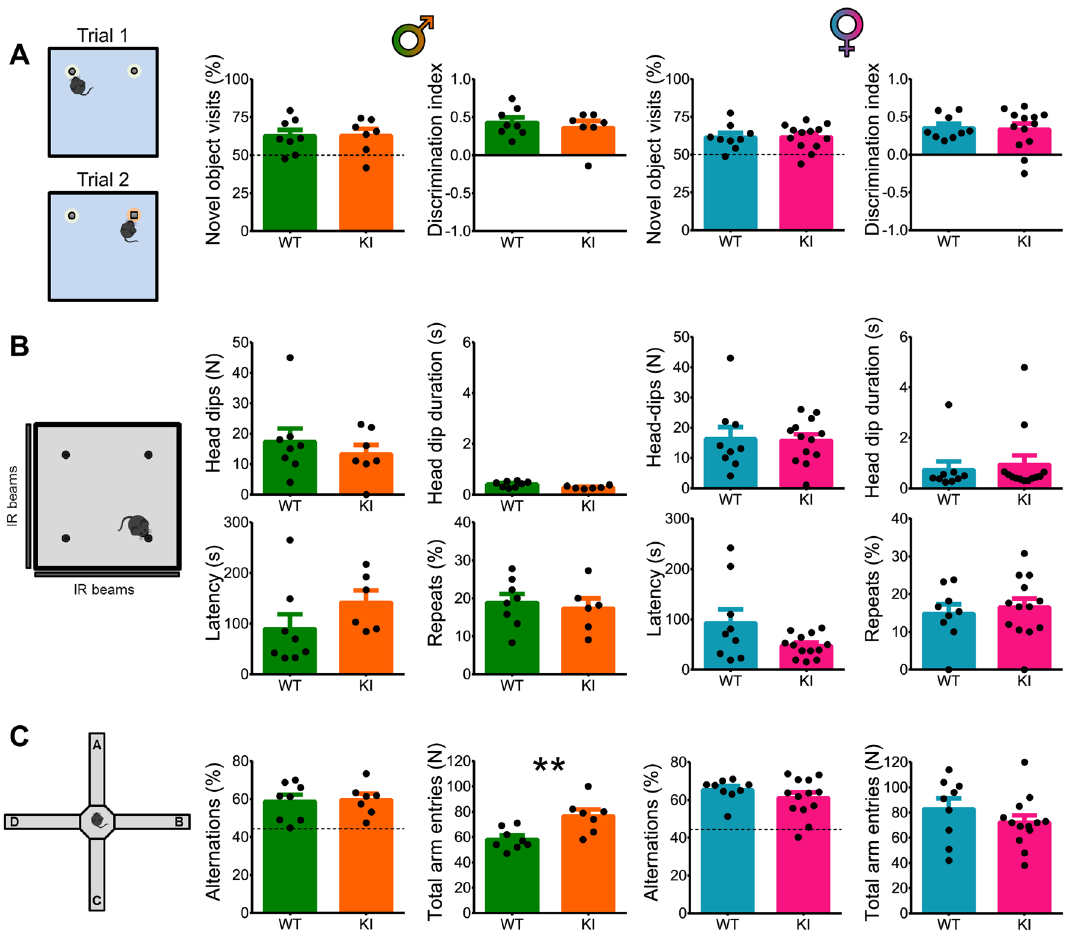
Figure 3. DAT-Cre KI does not affect novel object preference, hole-board exploration or working memory. ( A ) Results of the novel object preference test in KI and WT mice of both sexes. Learning is demonstrated by both the percentage of visits to the novel object in Trial 2 (in relation to all object visits), and by the discrimination index (ratio of time spent exploring the novel versus the familiar object). Both genotypes performed equally regardless of sex. ( B ) Measures of exploratory activity in the hole-board arena, including the number of head dips, average dip duration, latency to the first dip and the percentage of repeat dips. No difference between genotypes was found in both sexes. ( C ) Performance in the plus maze. Working memory in this task is measured by the percentage of spontaneous alternations in arm entries during maze exploration. All groups showed a similar percentage of spontaneous alternations. Note that male KI mice performed more arm entries (higher activity) than WT controls but had the same percentage of spontaneous alternations (no working memory differences). ** P <